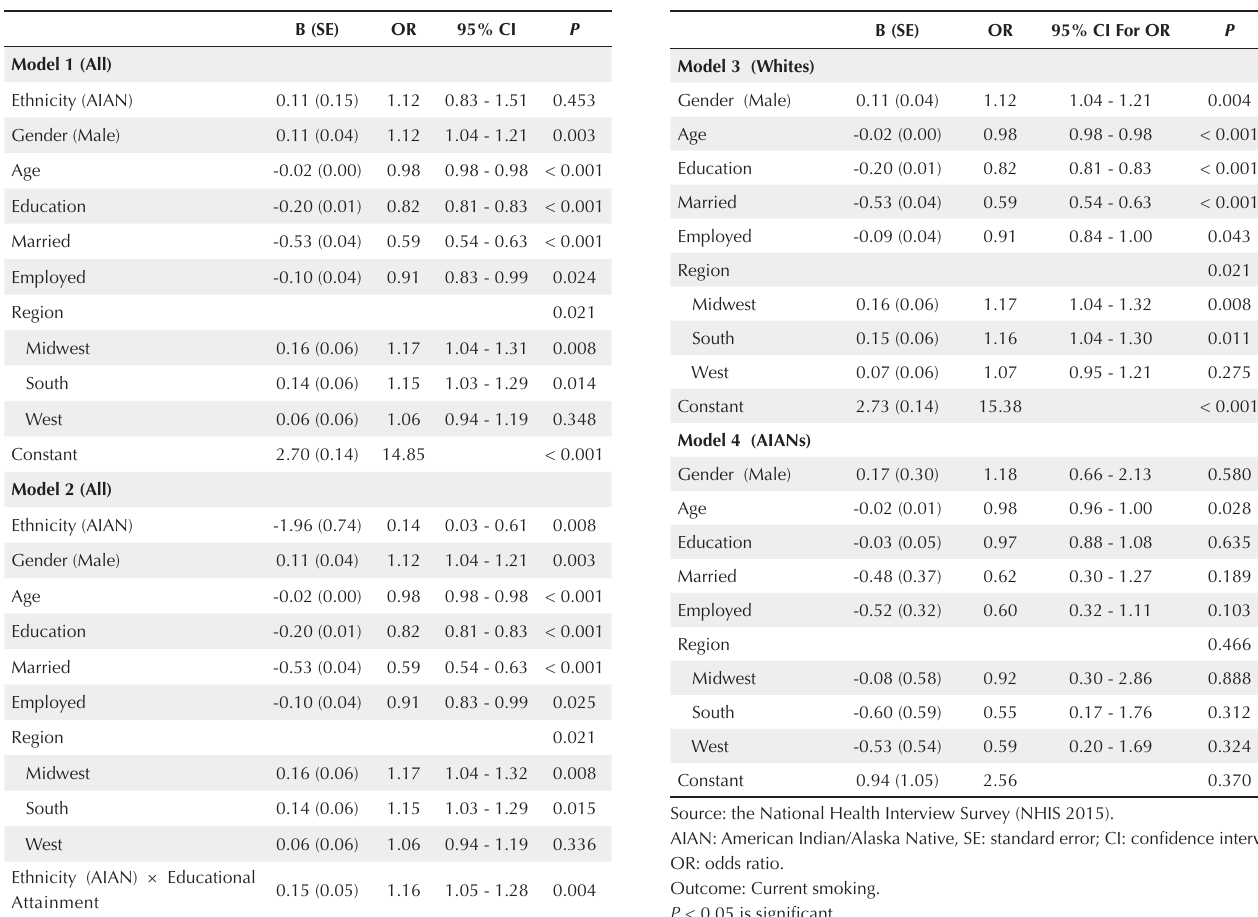
Table 2. Logistic Regression in the Pooled Sample Table 3. Logistic Regression in the Ethnic